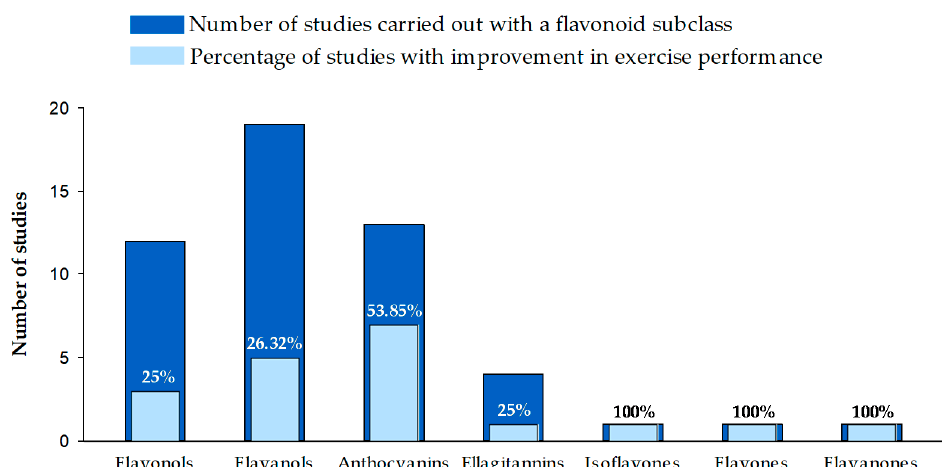
Figure 3. Summary of the included studies classified according to the flavonoid subclass and the percentage of studies reporting improvements in exercise performance.